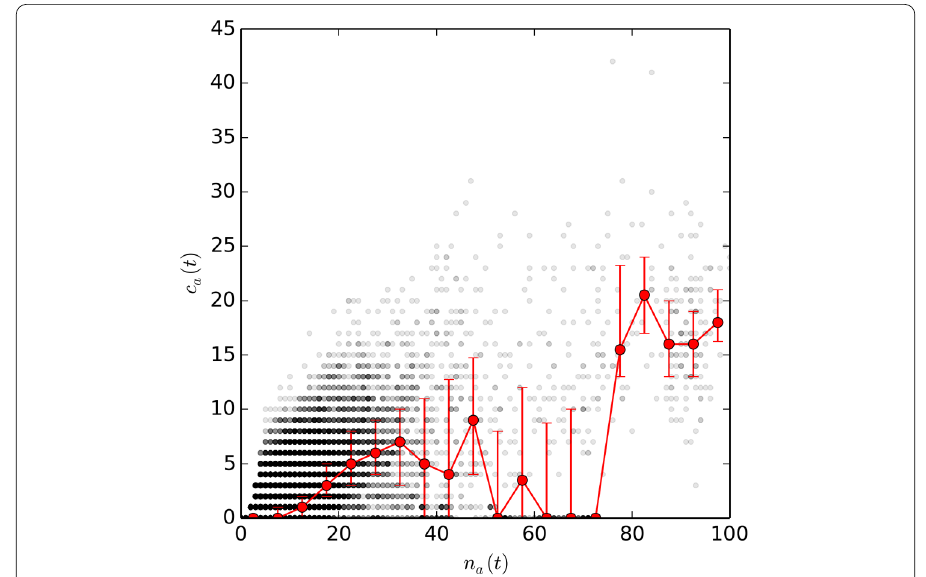
Figure 4 Number of contacts as a function of the number of individuals present—InVS15. We plot the number of contacts c a ( t ) occurring at time t in a certain area a as a function of the number of individuals n a ( t ) present at the same time in a . The red line shows the median of the scatter plot, with error bars defined by the 25% and 75%